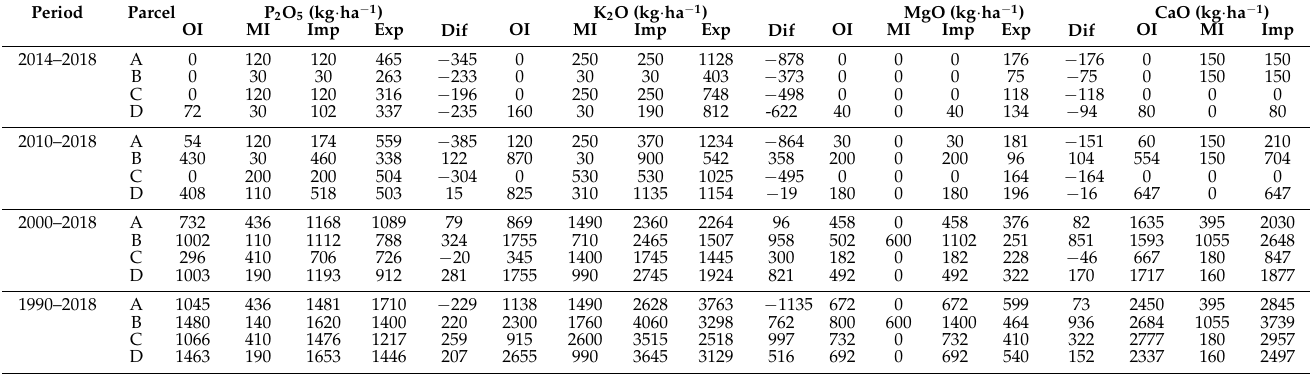
Table 5. Summary of historical P, K, Mg, and Ca nutrient import and export in each of the four parcels (A, B, C, and D) of the former field layout (see Figure 1). Annual data are summed for